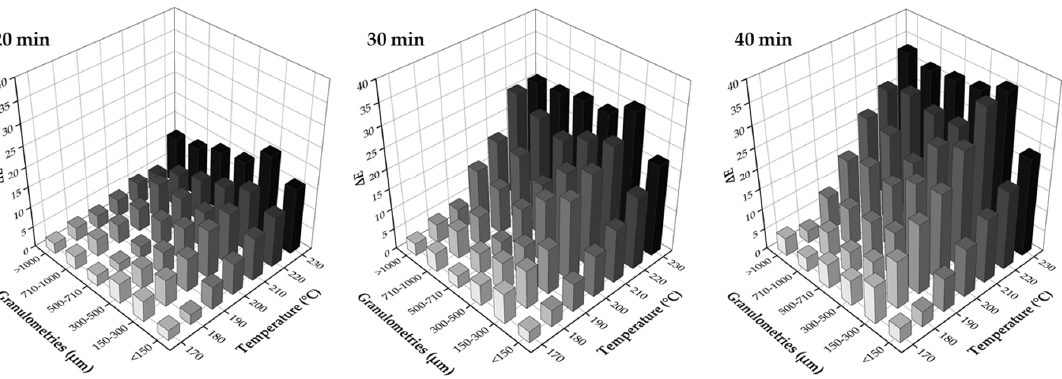
Figure 6. Color variation of wood particles with different granulometries, as a function of tempera- ture and time.